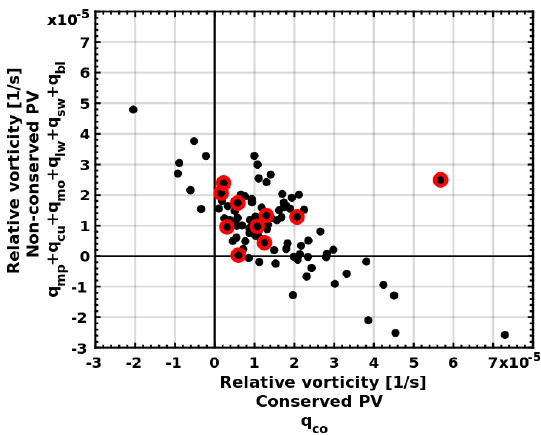
Figure 4. Scatterplot relating the contribution of different PV sources to the relative vorticity at 850hPa, in the centre of 100 intense cyclones: contributions of conserved, adiabatically trans- ported PV are shown on the x axis and non-conserved, diabatically produced PV are shown on the y axis. Red circles depict 10 medi- cane cases. Reprinted from Flaounas et al.